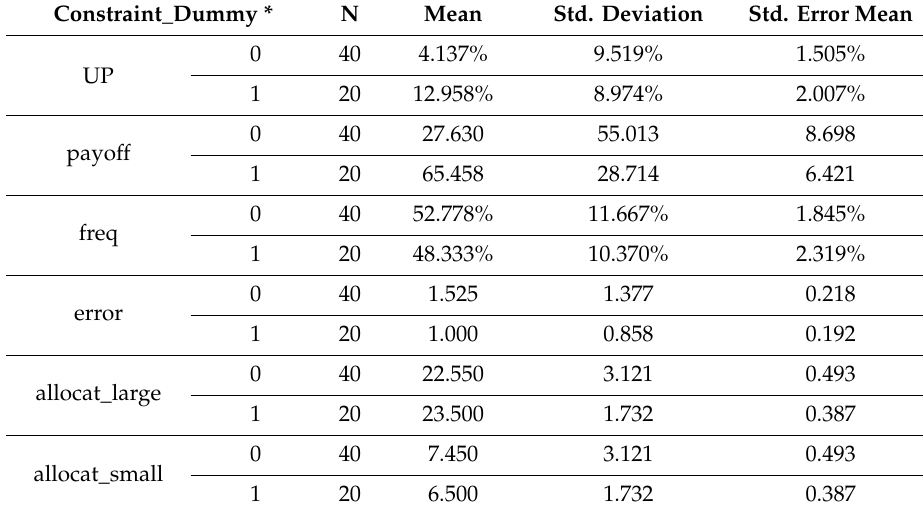
Table 10. Outcomes of the auctions with a discount in combination with the highest capacity constraint or with lower capacity